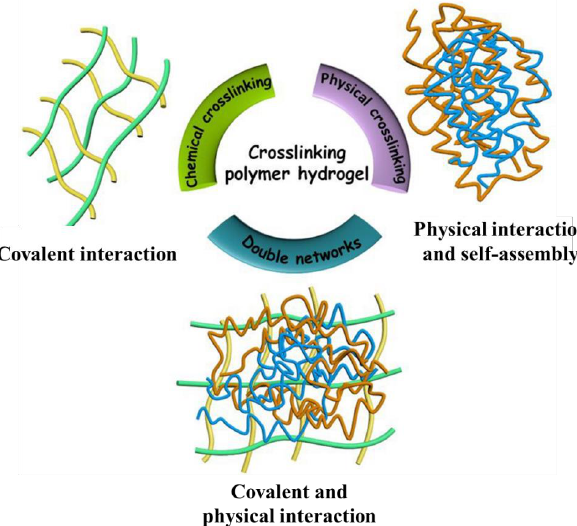
Figure 3. Schematic presentation of the hydrogels fabricated through chemical crosslinking, physi- cal crosslinking, or double network. Reprinted with permission from Ref. [61]. Copyright 2020, copyright with permission from Nandi, Mondal and Das.